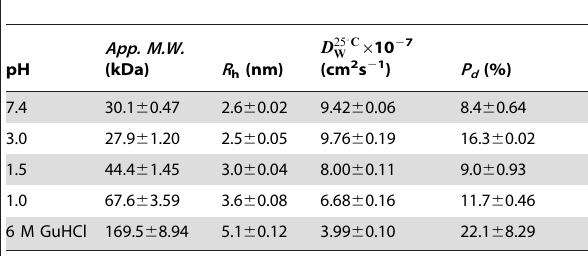
Table 4. Comparison of hydrodynamic radii ( R h ) and translational diffusion coefficients ( D 25 0 C different pH.